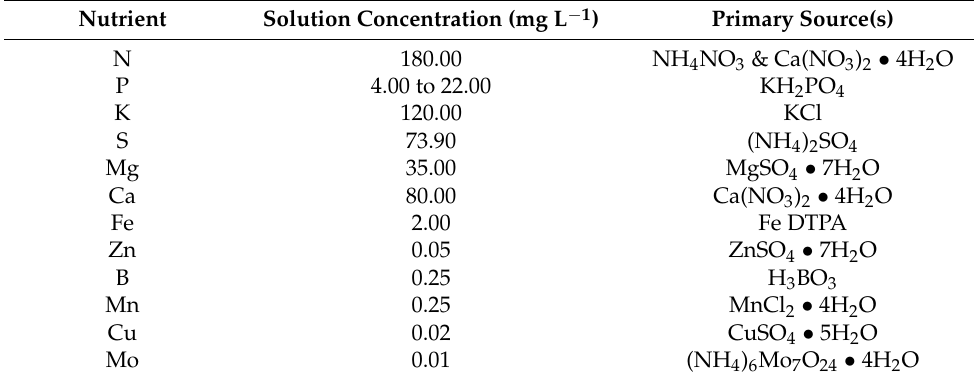
Table 1. Concentrations of plant essential elements in nutrient solution supplied to pots for fertigation and chemicals used to make the solutions. Final solution pH was 7.1 to